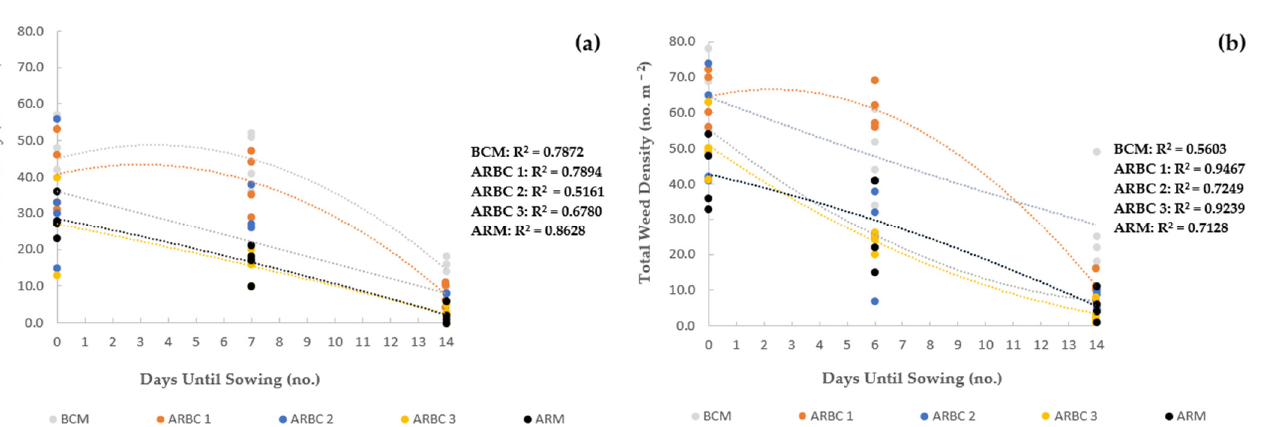
Figure 2. Second-degree polynomial relationships (y = ax 2 + bx + c, n = 12) between total weed density (no. m − 2 ; y) and days until sowing (no.; x) for each forage in ( a ) 2020–2021 and ( b ) 2021–2022 (“no.” is the abbreviation of “number”). BCM: Berseem clover monoculture; ARBC 1: First intercrop with annual ryegrass and berseem clover in a 25:75 ratio; ARBC 2: Second intercrop with annual ryegrass and berseem clover in a 50:50 ratio; ARBC 3: Third intercrop with annual ryegrass and berseem clover in a 75:25 ratio; ARM: Annual ryegrass monoculture (see text in Section 2.2 for details on abbreviations).